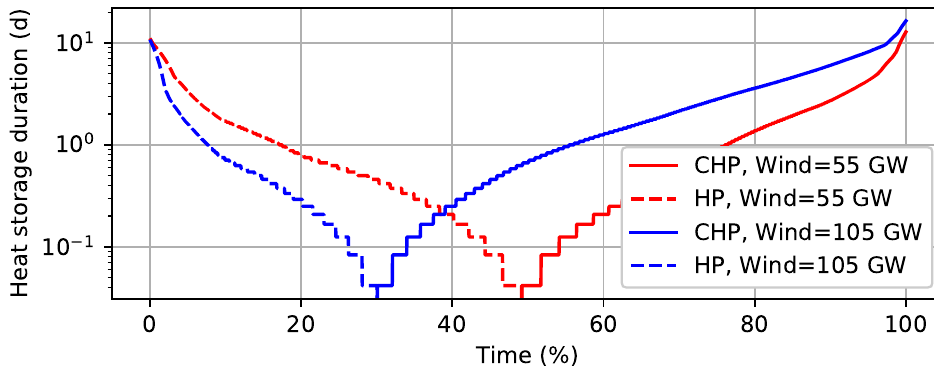
Figure 7. Duration curves of the time since the last moment the CHP was competitive. (Steps are due to hourly time